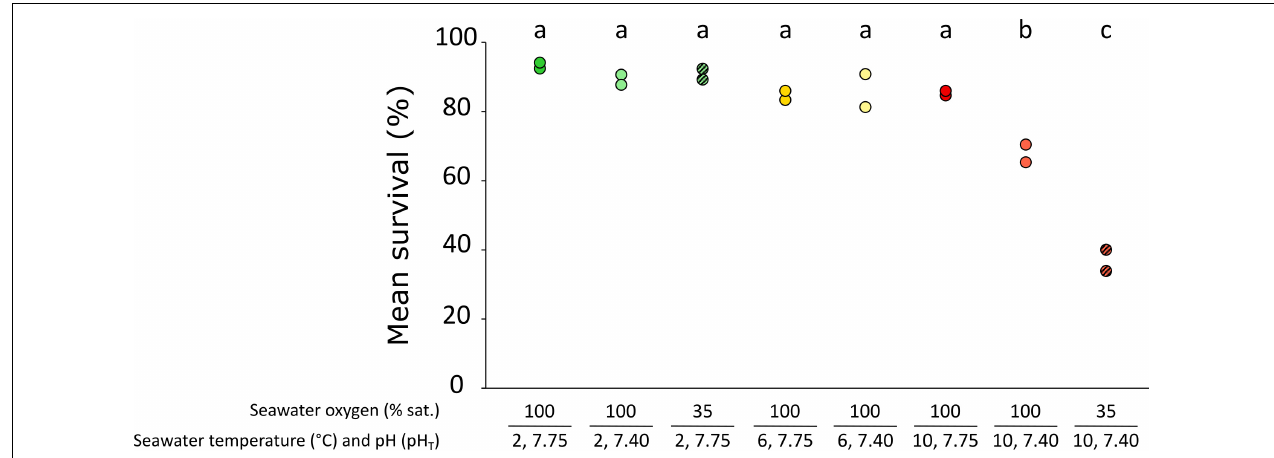
FIGURE 1 | The effect of exposure to elevated temperature, low pH and low oxygen in isolation and combined for 30 days on mean survival (%) of females of the Northern shrimp Pandalus borealis . Treatment symbols correspond to 2C: 2 ◦ C, pH 7.75, O 2 sat. 100% (dark green); 2A: 2 ◦ C, pH 7.4, O 2 sat. 100% (light green); 2CH: 2 ◦ C, pH 7.75, O 2 sat. 35% (light striped green); 6C: 6 ◦ C, pH 7.75, O 2 sat. 100% (dark orange); 6A: 6 ◦ C, pH 7.4, O 2 sat. 100% (light orange); 10C: 10 ◦ C, pH 7.75, O 2 sat. 100% (dark red); 10A: 10 ◦ C, pH 7.4, O 2 sat. 100% (light red); 10AH: 10 ◦ C, pH 7.4, O 2 sat. 35% (light striped red). Dots represent mean percentage survival values for each tank. Lower case letters indicate significant differences ( p < 0.05) between